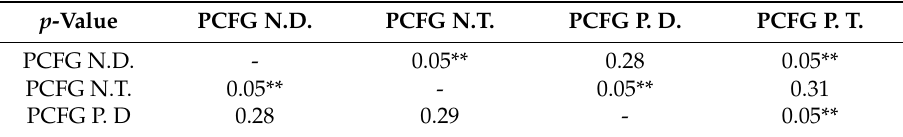
Table 4. A Wilcoxon signed-rank test comparing the paired set of selected top 100 PCFG rules in each category of hotel reviews.